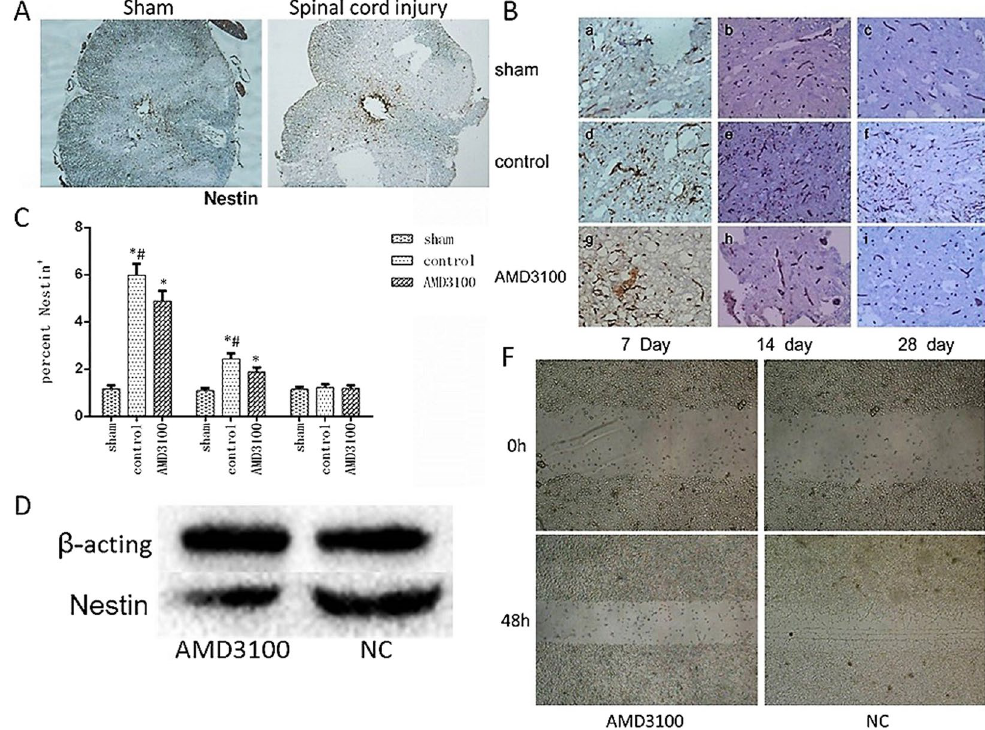
Figure 4. The expression of Nestin protein in neural stem cell after treated with AMD3100. ( A ) Representative images of IHC staining of Nestin in sham and untreated groups of rats ( × 40). It showed that the expression of Nestin protein increased at the injured site after SCI in rats comparing with those without SCI, especially in the region around central canal of spinal cord. ( B ) Representative images of IHC staining of Nestin in the three groups of rats ( × 400). It showed that the expression of Nestin increased in both of AMD3100 and untreated groups after SCI. ( C ) The expression of Nestin protein was measured in the three groups of rats. It revealed that the Nestin protein was inhibited by AMD3100. ( D ) The expression of Nestin protein in RASNF-01001 cells was significantly decreased in AMD3100 group. ( F ) The wound healing assay showed the migration ability of RASNF-01001 cells was reduced by AMD3100. ( * P < 0.05: untreated group vs. sham group, AMD3100 group vs. sham group; # P < 0.05: AMD3100 group vs. untreated